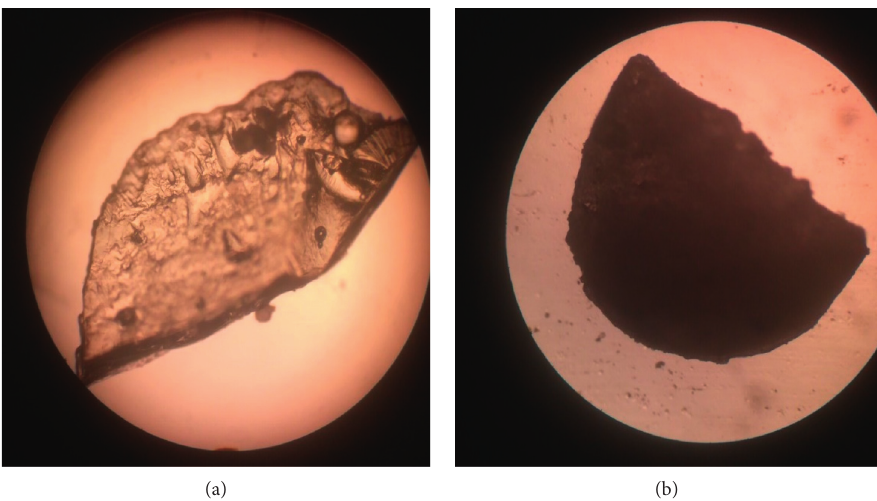
Figure 14: The fracture figure of the microbial capsule under pressure: (a) broken wall material; (b) core material.